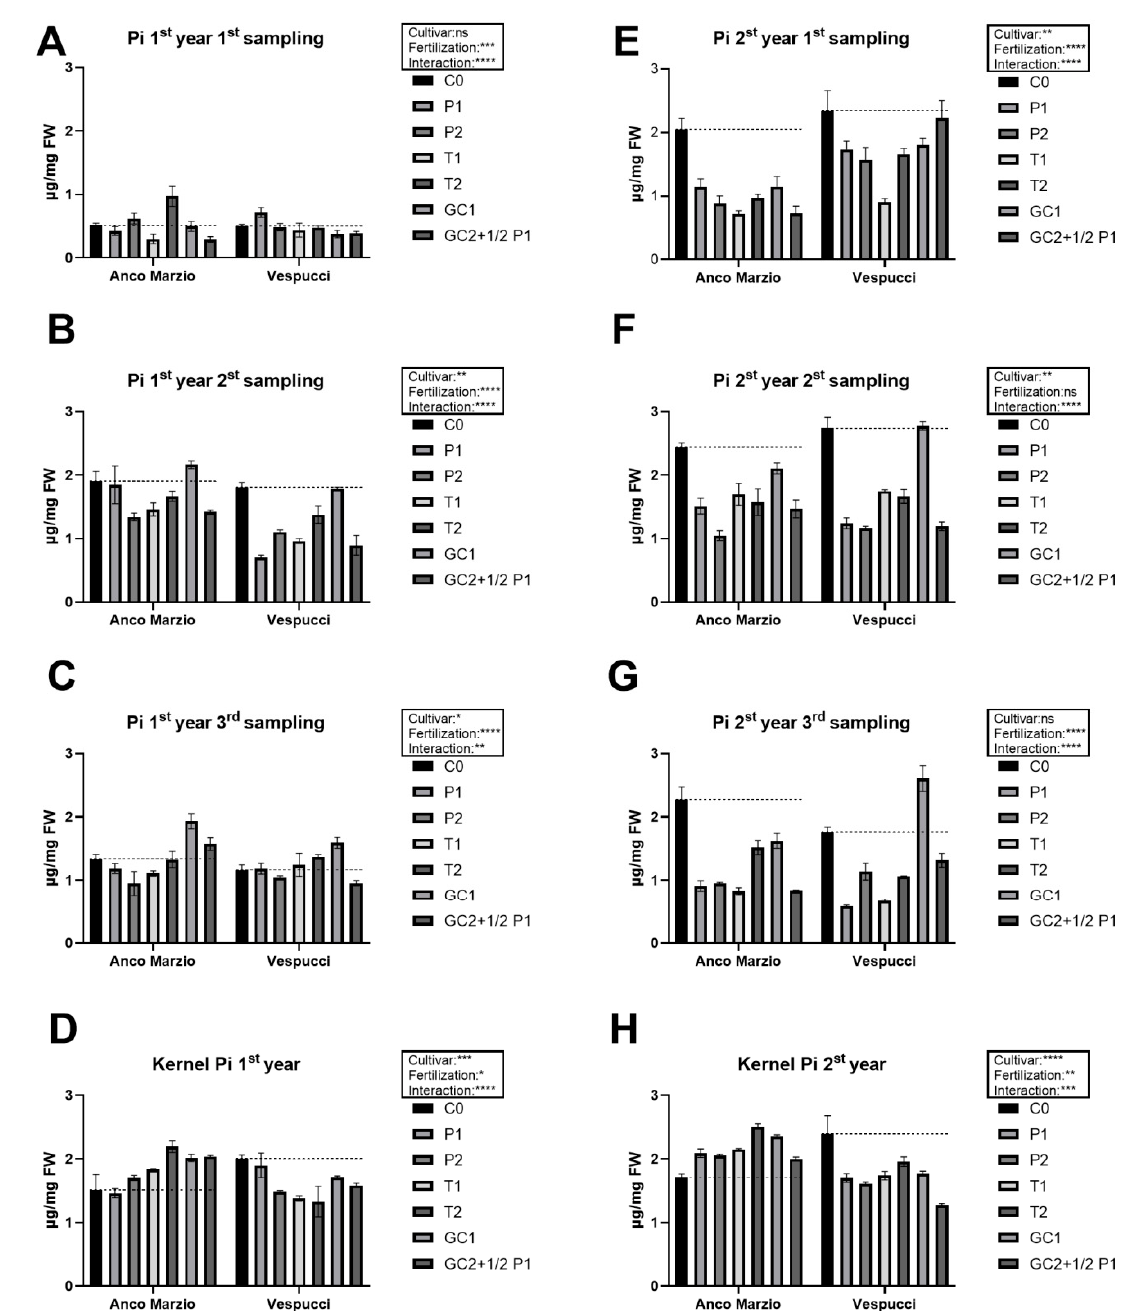
Figure 11. Phosphate content (Pi) on the leaf (at three crop stages) and kernel (at the stage of ripening) samples. Data are related to the first and second year of analyses. Data were reported by indicating the statistical significance of two factors (Cultivar and Fertilization) and their interaction. Data are reported with p -values. * p ≤ 0.05; ** p ≤ 0.01; *** p ≤ 0.001; **** p ≤ 0.0001.